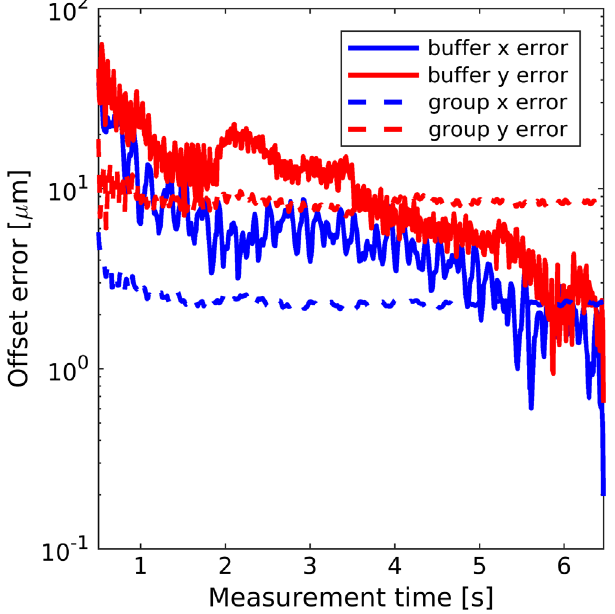
FIG. 11. Measured average of 5 BPM offset errors as a function of the acquisition time for a (dc) skew quadrupole FBBA.